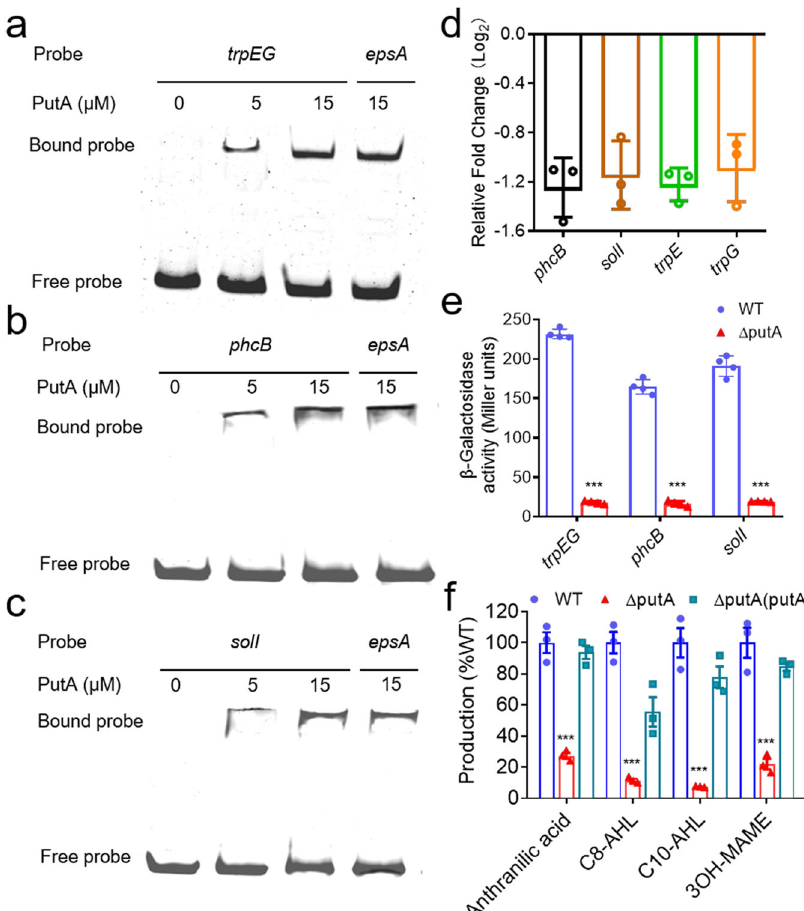
Fig. 5 Effects of PutA on the signalling systems. EMSA analysis of the binding of PutA to the promoters of trpEG ( a ) , phcB ( b ) and solI ( c ) in vitro. Biotin- labelled 291-bp trpEG , 327-bp phcB and 324-bp solI promoter DNA probes were used for the protein binding assay. The effects of putA on the expression of signal synthase-encoding genes were evaluated by RT-qPCR (OD 600 = 1.0) ( d ) and by assessing the β -galactosidase activity of the trpEG - lacZ , phcB - lacZ and solI - lacZ transcriptional fusions in the wild-type and putA mutant strains (OD 600 = 3.0) ( e ). The signal production in the wild-type, putA mutant and putA complement strains was analysed by using UPLC-MS spectrometry. The amount of each signal in the R. solanacearum wild-type strain was arbitrarily de fi ned as 100% and used to normalize the amount of that signal in the putA mutant and complement strains ( f ). In a , b and c experiment was performed three times and representative images from one experiment are shown. Results in d , e and f are mean ± standard deviations of three or four independent experiments. * p < 0.05; ** p < 0.01; *** p < 0.001 (unpaired t